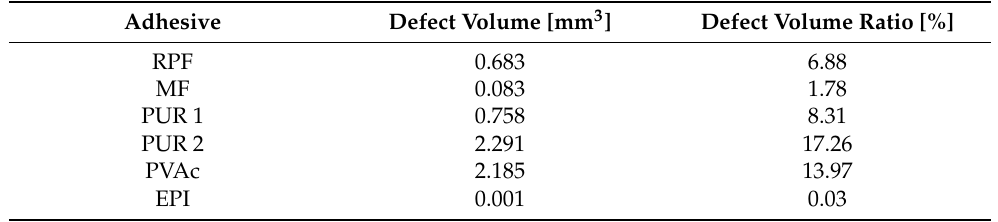
Table 4. Proportion of the voids in the adhesive joints.